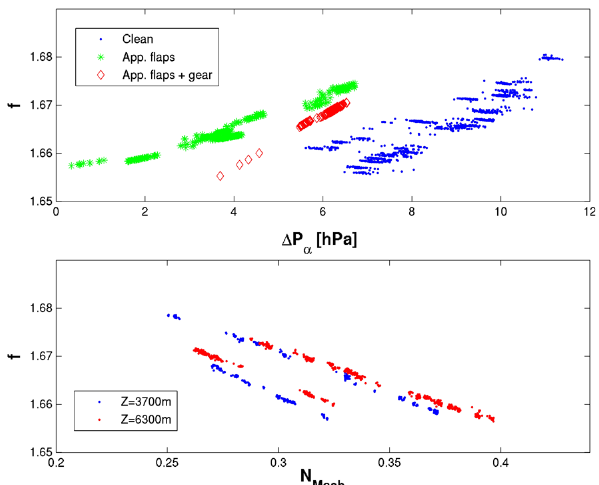
Fig. 3. Scatter plots (10Hz data) of probe sensitivity factor f , cal- culated from the solution of Eq. (2), versus 1P α [ hPa ] (top panel), and Mach number (bottom panel) for various flight configurations and altitudes, as indicated in